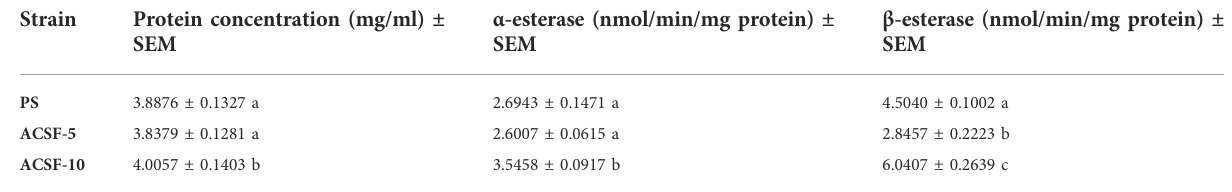
TABLE 2 Comparative mean protein concentration and α -esterase activity in parent and acetamiprid larval-selected strains of Aedes aegypti.